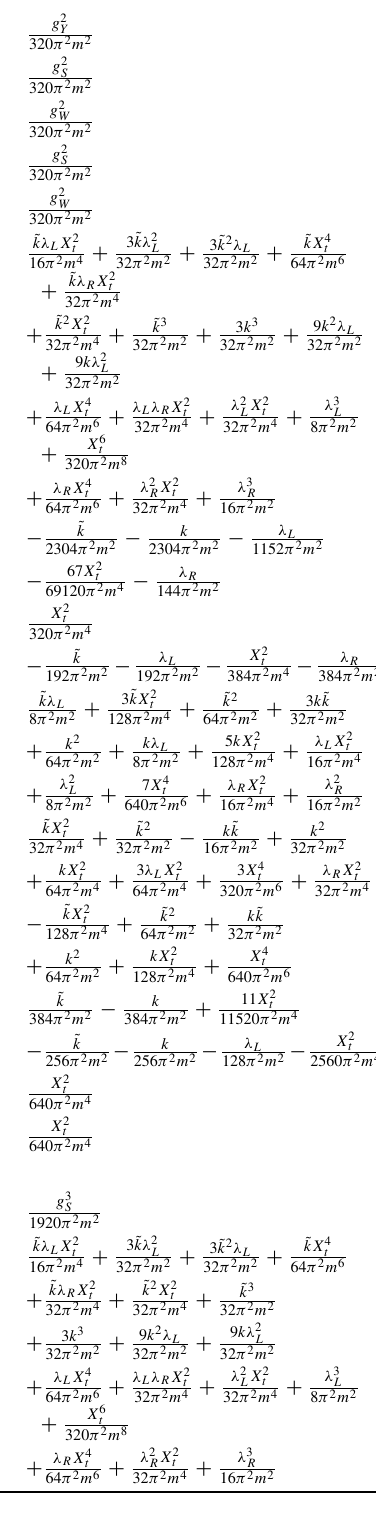
and Wilson coefficients for colored complex SU ( 2 ) L doublet and singlets models. These two fields are degenerate = m ˜ = in mass, i.e., m ˜ t R Q 3 L